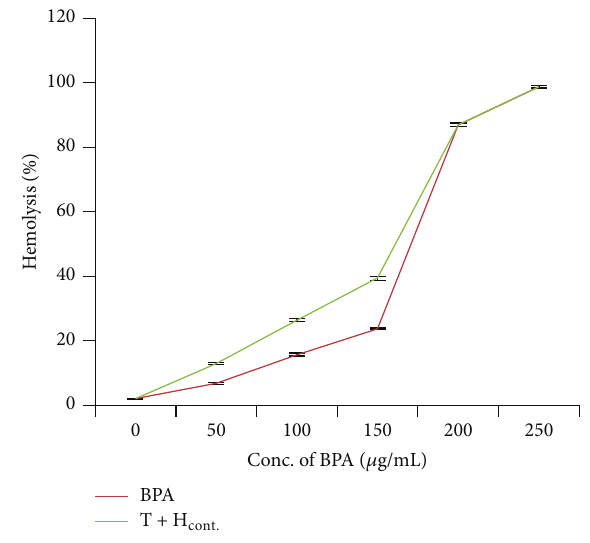
Figure 2: Effect of bisphenol A alone and its combination with hydrogen peroxide on red blood corpuscles. Results are expressed as mean ± SEM; 𝑛 = 10 . ∗ Significant at the level 𝑃 < 0.05 as compared to